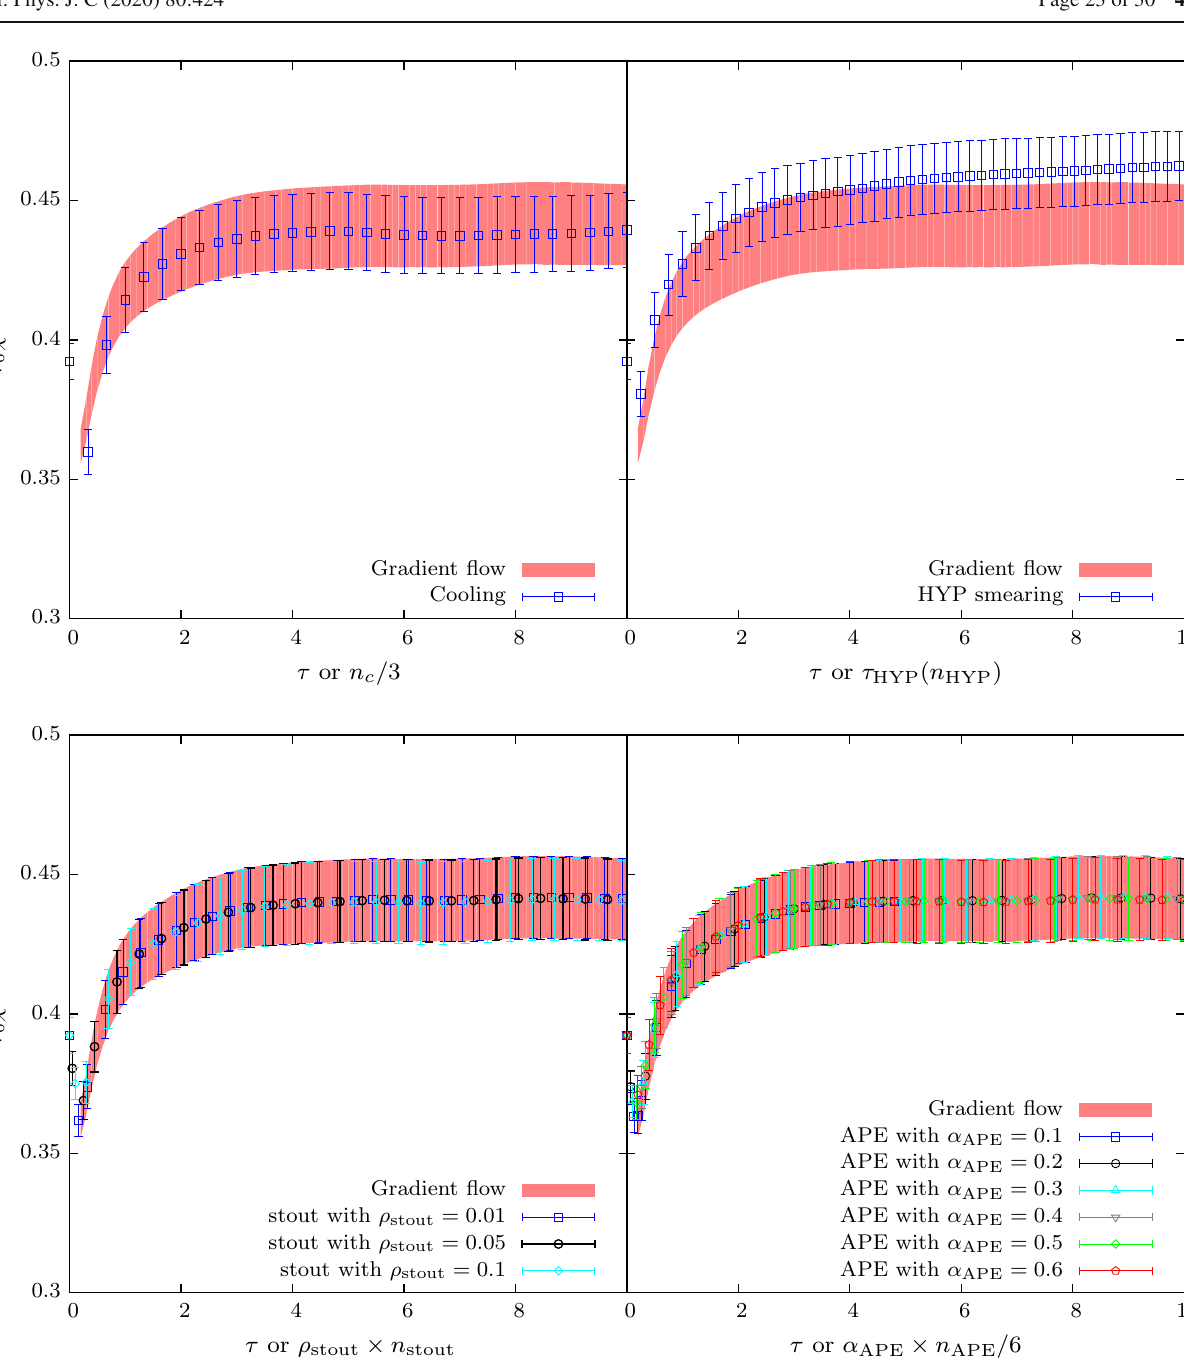
lower left panel, the rescaled n stout smearing ρ st × n stout for three values of ρ st , or, finally in the lower right panel, the rescaled APE smearing α × n / 6 for six different values of the α APE APE APE parameter. For this ensemble t 0 (cid:19) 2 . 5 a